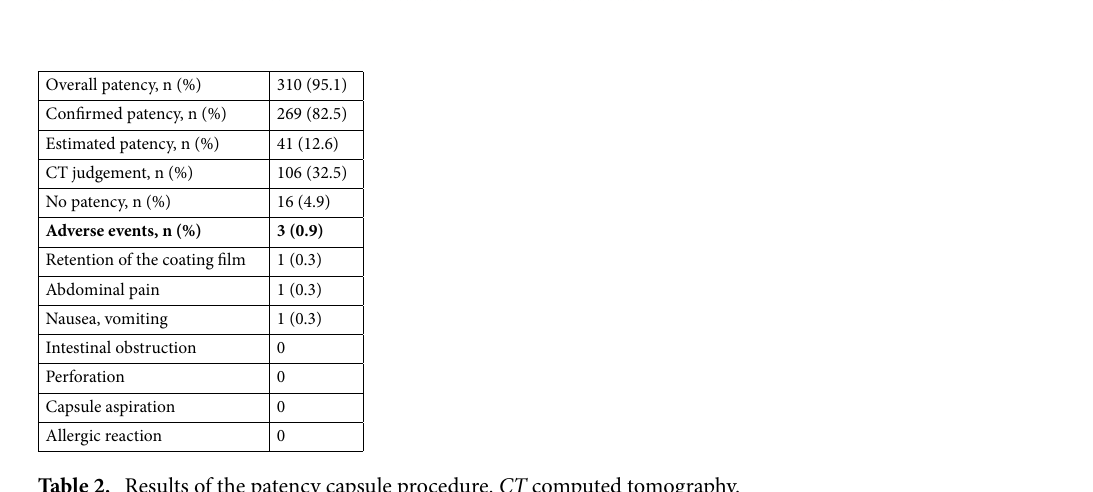
Figure 1. Study flow diagram.